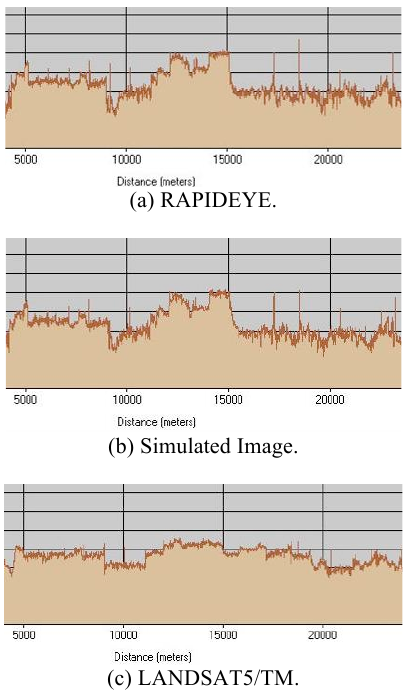
Figure 9. Red band radiometric profile of (a) RAPIDEYE image, (b) simulated image and (c) real LANDSAT